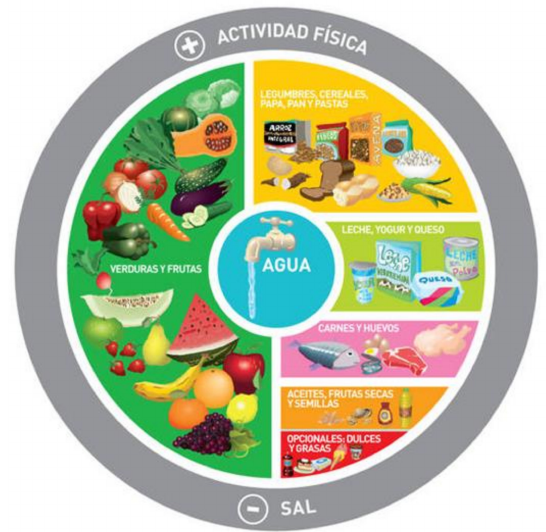
Figure 6. Food-based dietary guidelines—Argentina